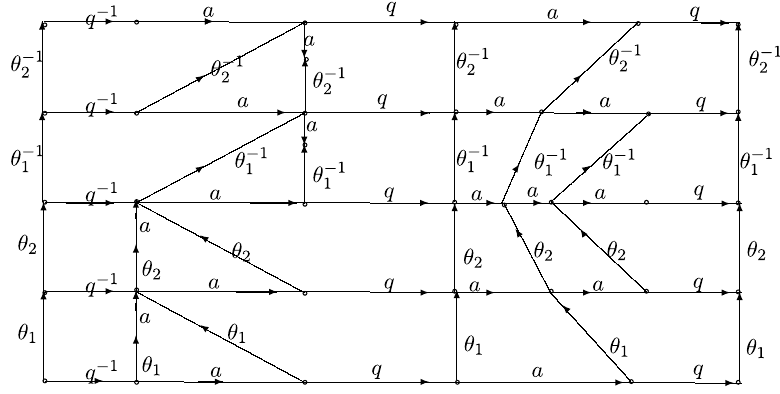
Fig. 1. The trapezium corresponding to a computation of S